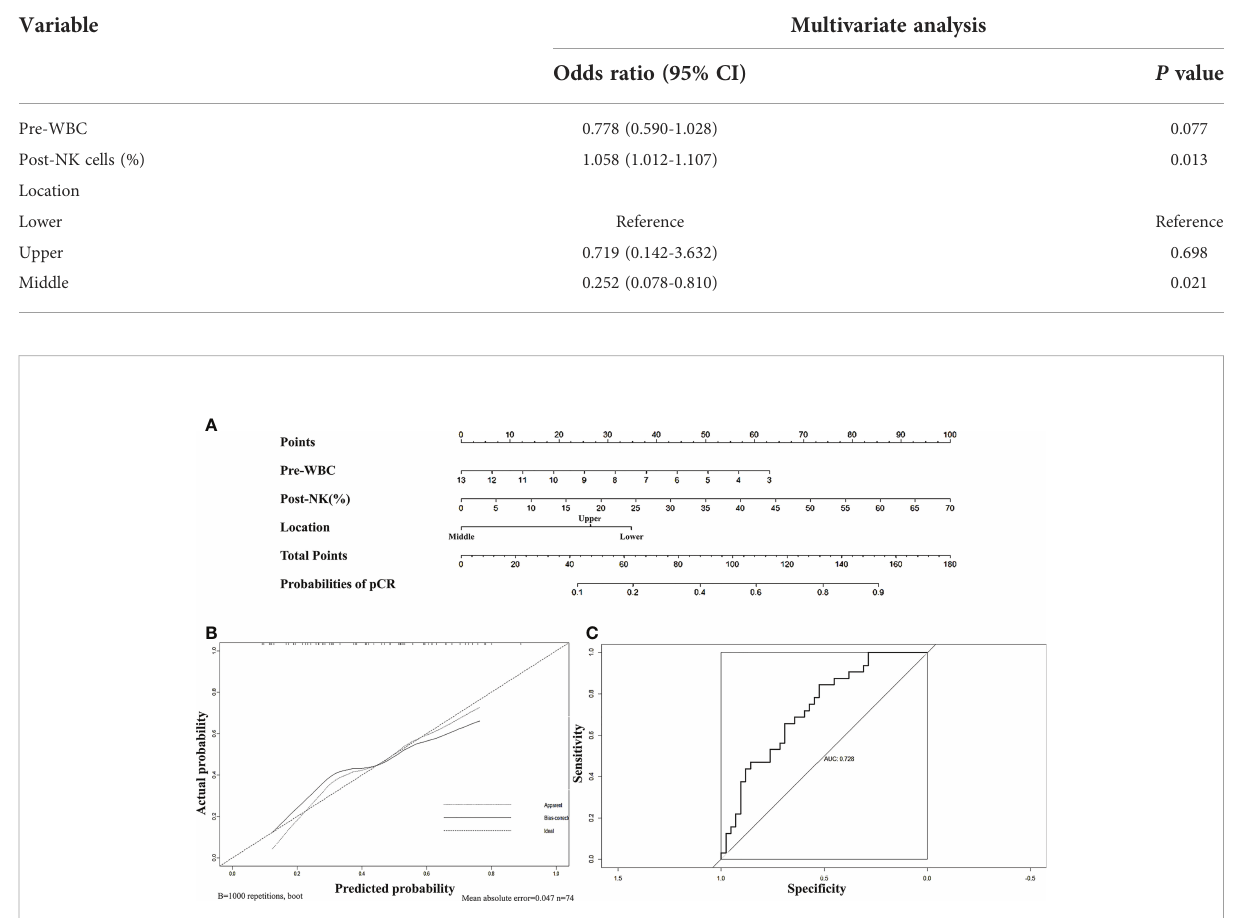
TABLE 5 Multivariate analysis of pCR.